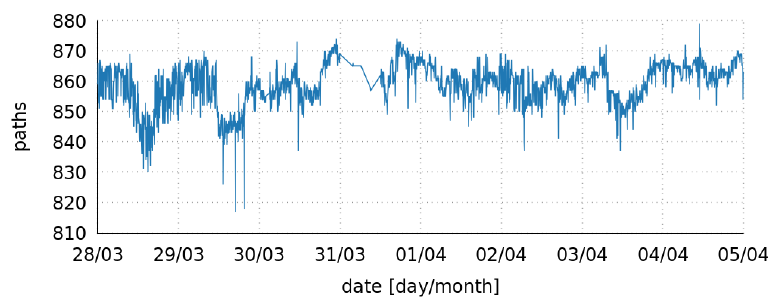
Figure 2. Temporal evolution of the number of paths.